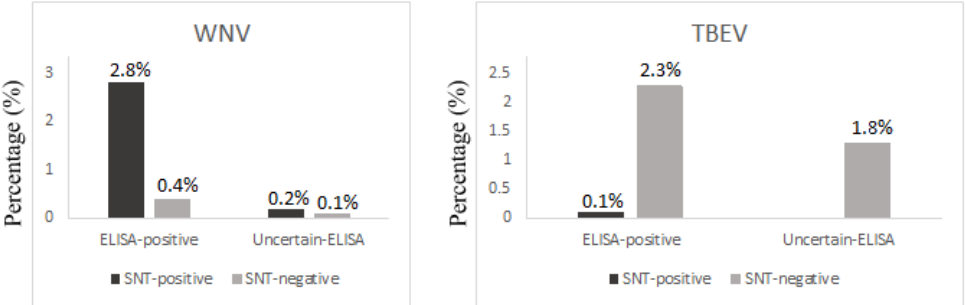
Figure 1. SNT results for confirmation of ELISA-positive or ELISA-equivocal IgG results.